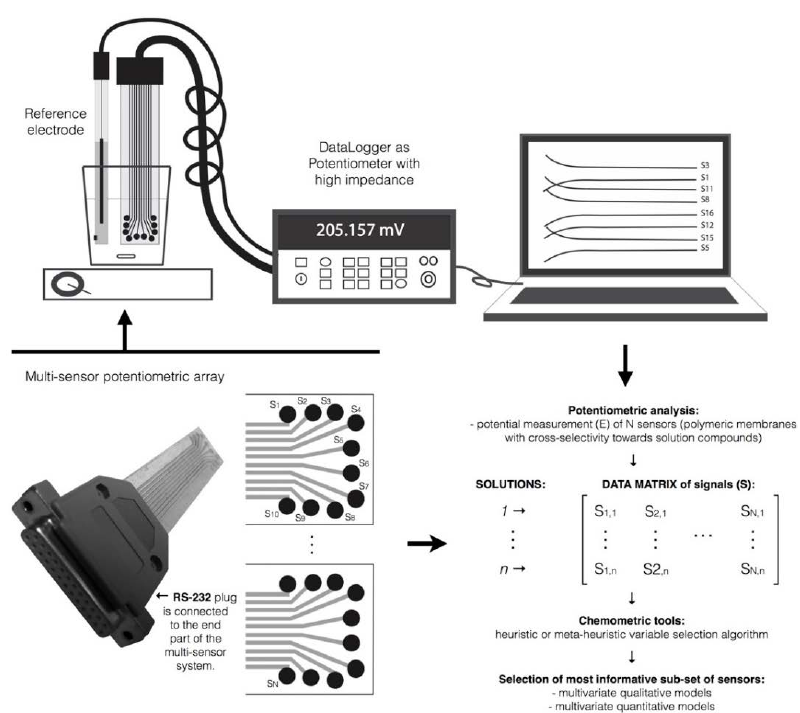
Figure 1. Database of signal profiles generated by a potentiometric E-tongue device comprising K sensor arrays each with N sensors, during the analysis of M samples.